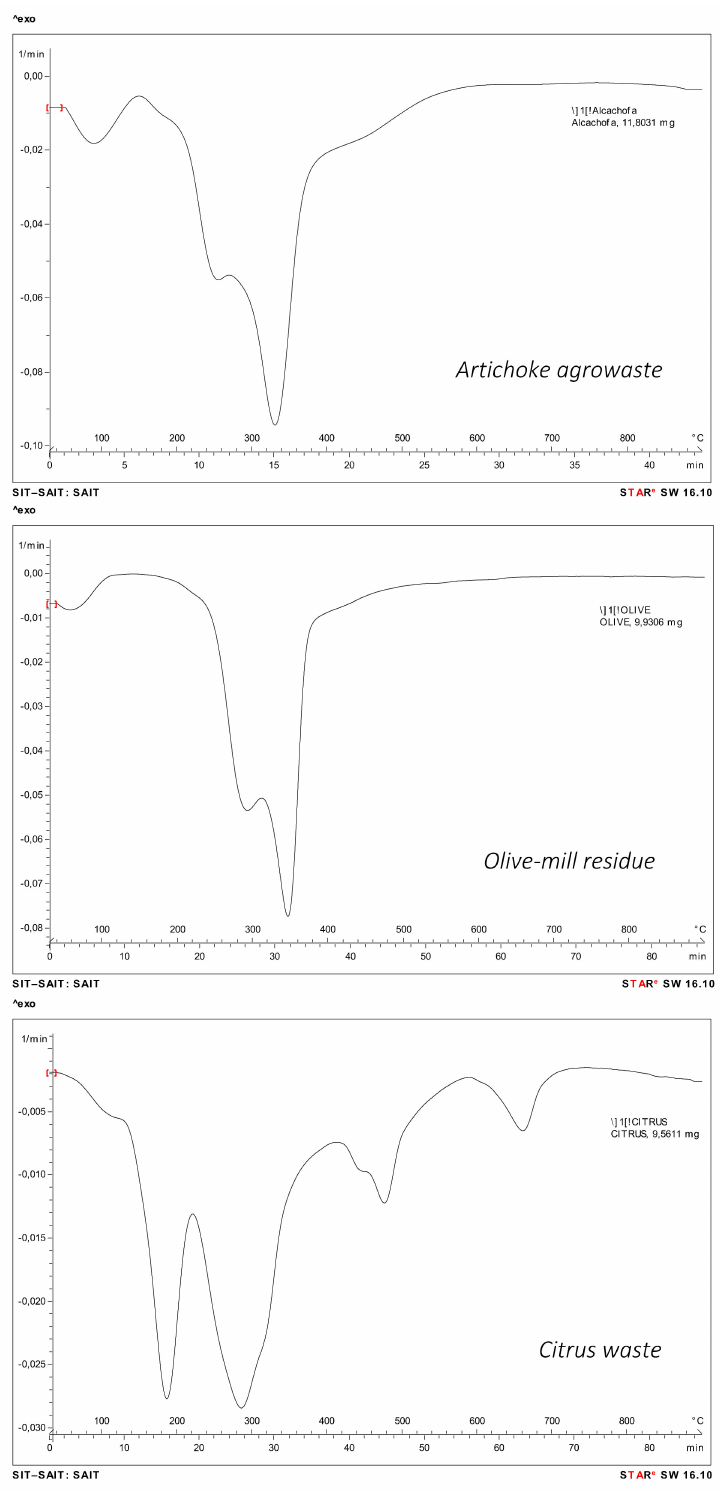
Figure 4. Differential thermogravimetry curves for the selected agrifood